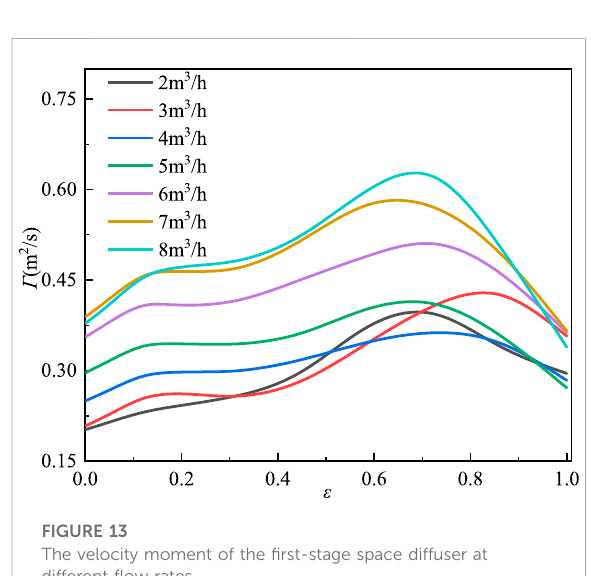
FIGURE 12 The velocity moment of the fi rst-stage space diffuser at different outlet setting angles.